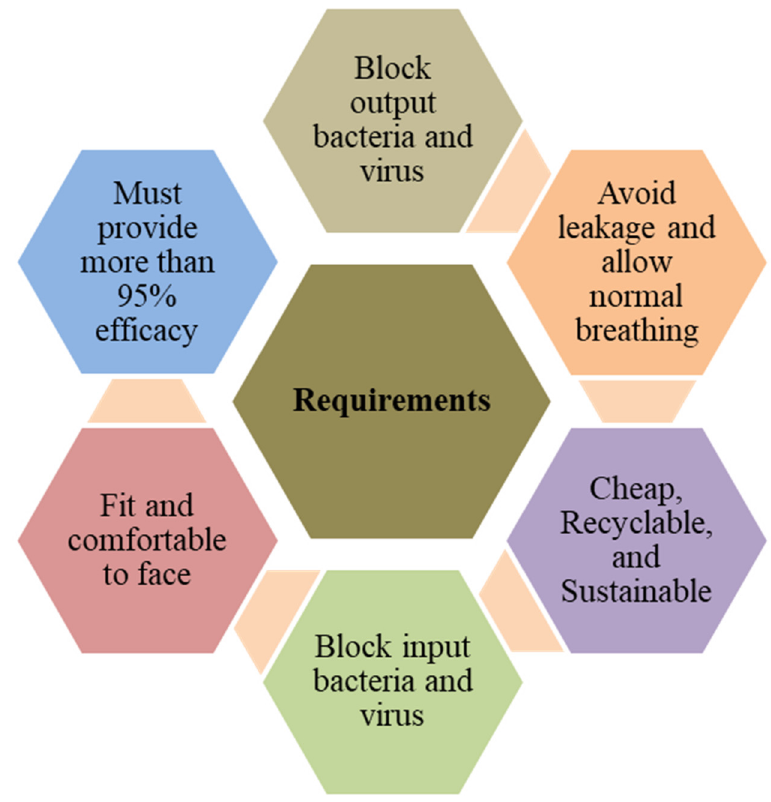
Figure 1. Major requirements of face